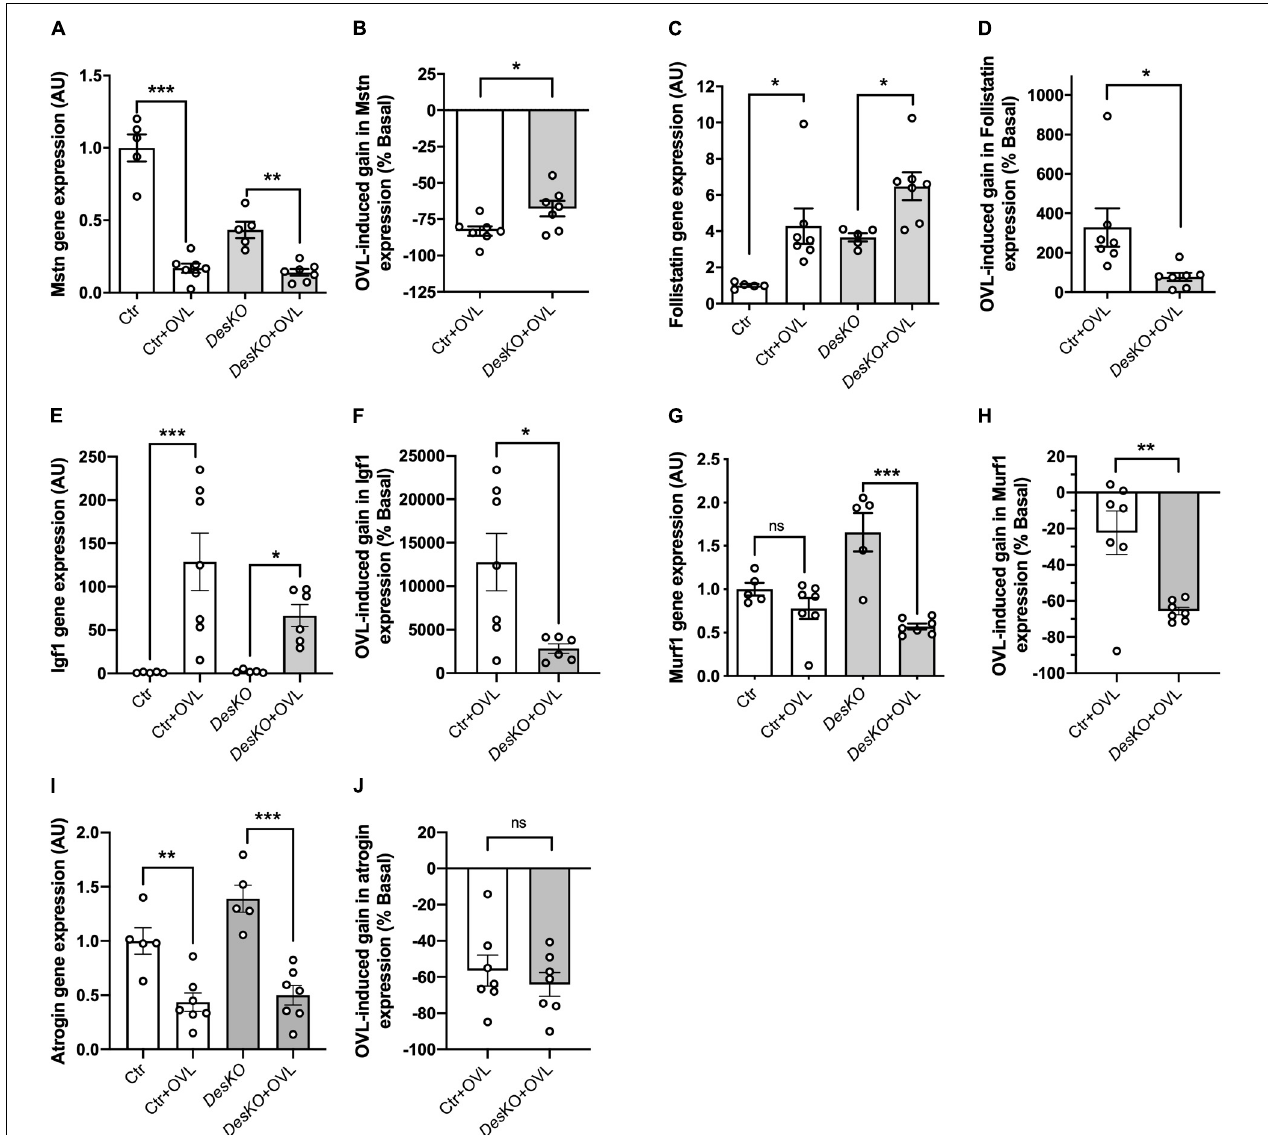
FIGURE 3 | Expression of genes involved in the regulation of muscle mass pathways regulation is modified in DesKO mice after OVL. Gene expression of the hypertrophic markers myostatin (A,B) , Follistatin (C,D) , Igf1 (E,F) and of the anti-hypertrophic markers Murf1 (G,H) and Atrogin (I,J) were evaluated in both genotype (Ctr and Des KO) in basal condition or after 7 days of OVL. The gain or loss of expression of these genes was calculated compared to the corresponding basal condition for the Ctr + OVL and Des KO + OVL groups (B,D,F,H,J) . Data are given as means ± SEM. Des KO, Desmin knock-out mice; Ctr, Control mice; OVL, mechanical overloading. ns, non-significant, * p < 0.05, ** p < 0.01, *** p <